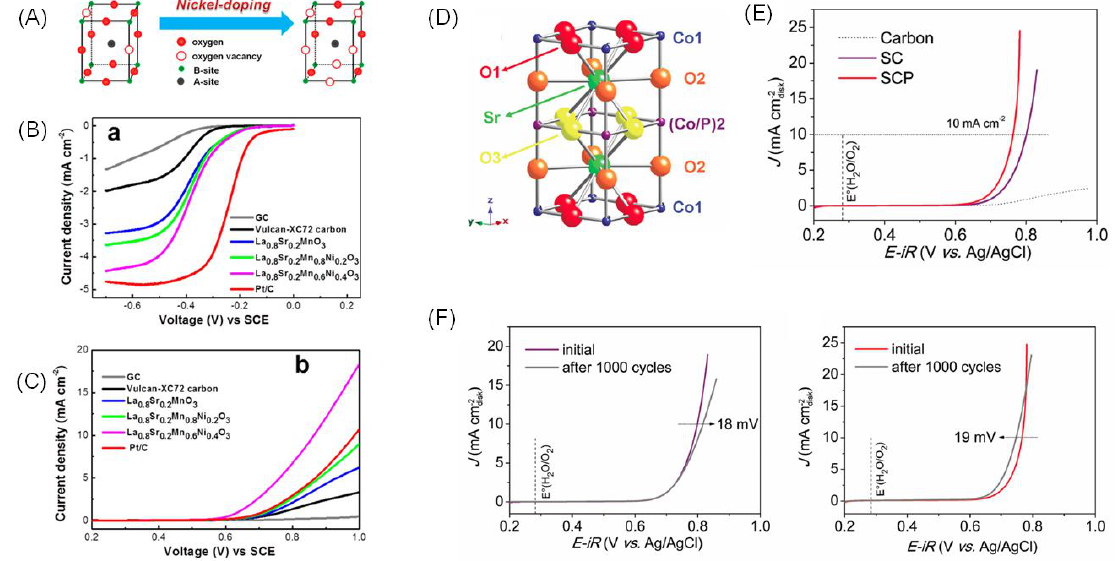
Figure 3. ( A ) Scheme showing the Ni doping on La 0.8 Sr 0.2 MnO 3 (adapted from [56], with permission from American Chemical Society, 2016). ( B ) ORR and ( C ) OER performance of La 0.8 Sr 0.2 Mn 0.6 Ni 0.4 O 3 in O 2 -saturated 0.1 M KOH (adapted from [56], with permission from American Chemical Society, 2016) ( D ) Scheme showing the tetragonal crystal structure of SrCo 0.95 P 0.05 O 3 − δ (SCP) (adapted from